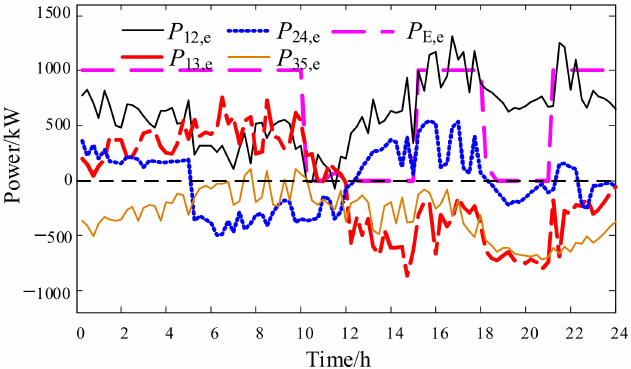
Figure 10. Electrical power exchange between multi-energy stations in the